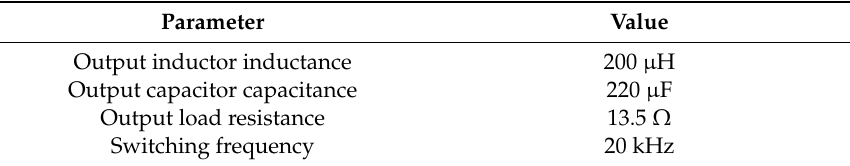
Table 3. Specifications and parameters of the experiment.